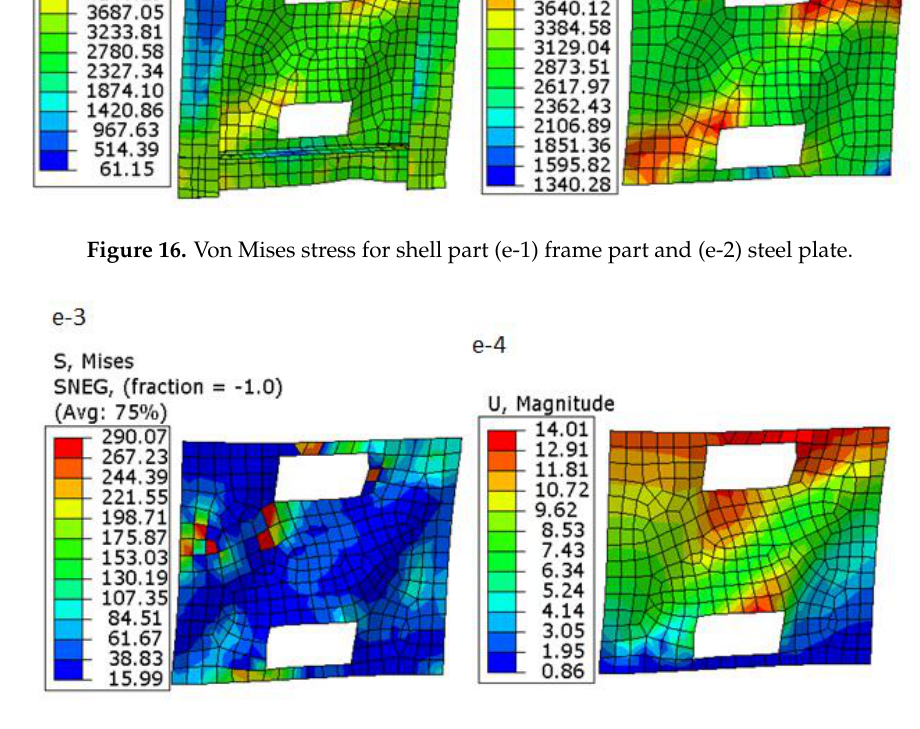
Figure 17. Von Mises stress and displacement for concrete part (e-3) stress and (e-4) displacement.